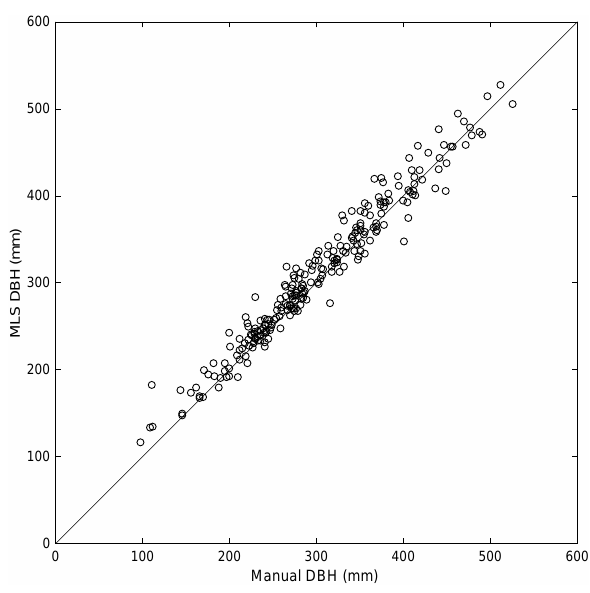
Figure 5. Stem diameter estimates 1.3 m above ground (DBH).